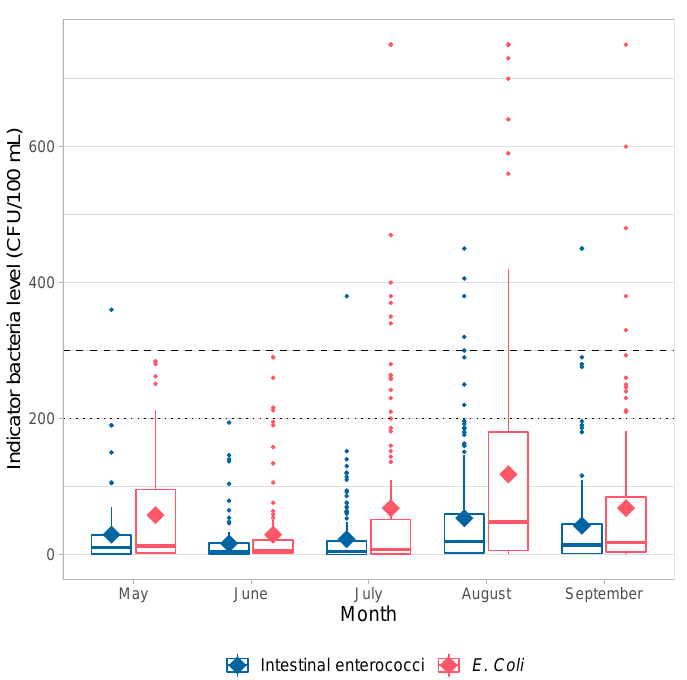
Figure 6. Summary of FIB levels grouped by months. The blue color represents intestinal enterococci and the red color E. coli . The line represents median and diamond shape mean values. The dashed line is the threshold for E. coli exceedance and the dotted line is the threshold for intestinal